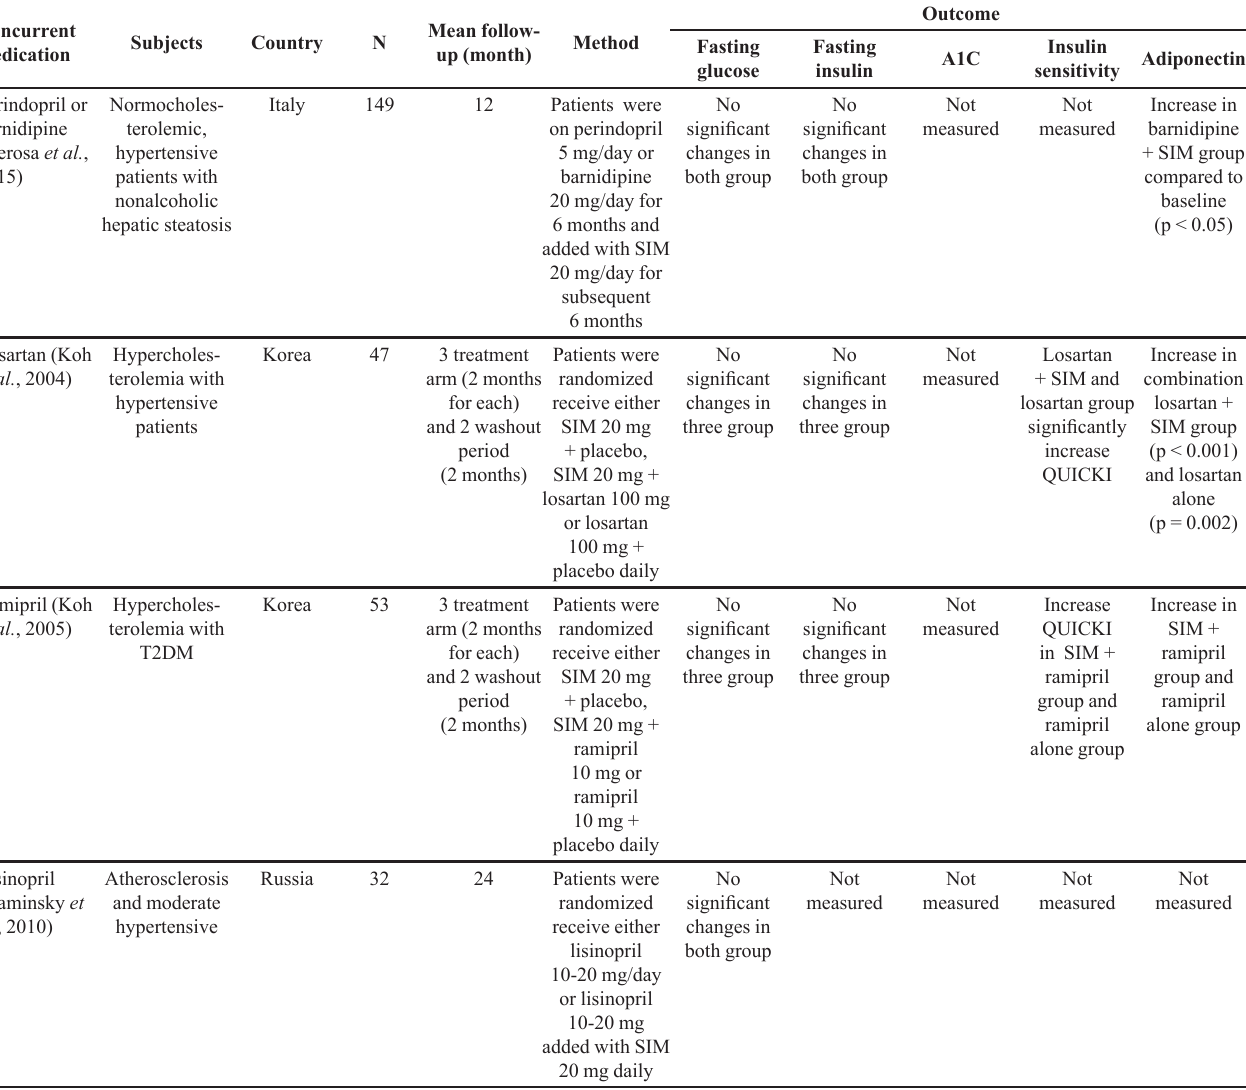
TABLE V - The effect of concurrent medications in combination with simvastatin (antihypertensive agents) Concurrent